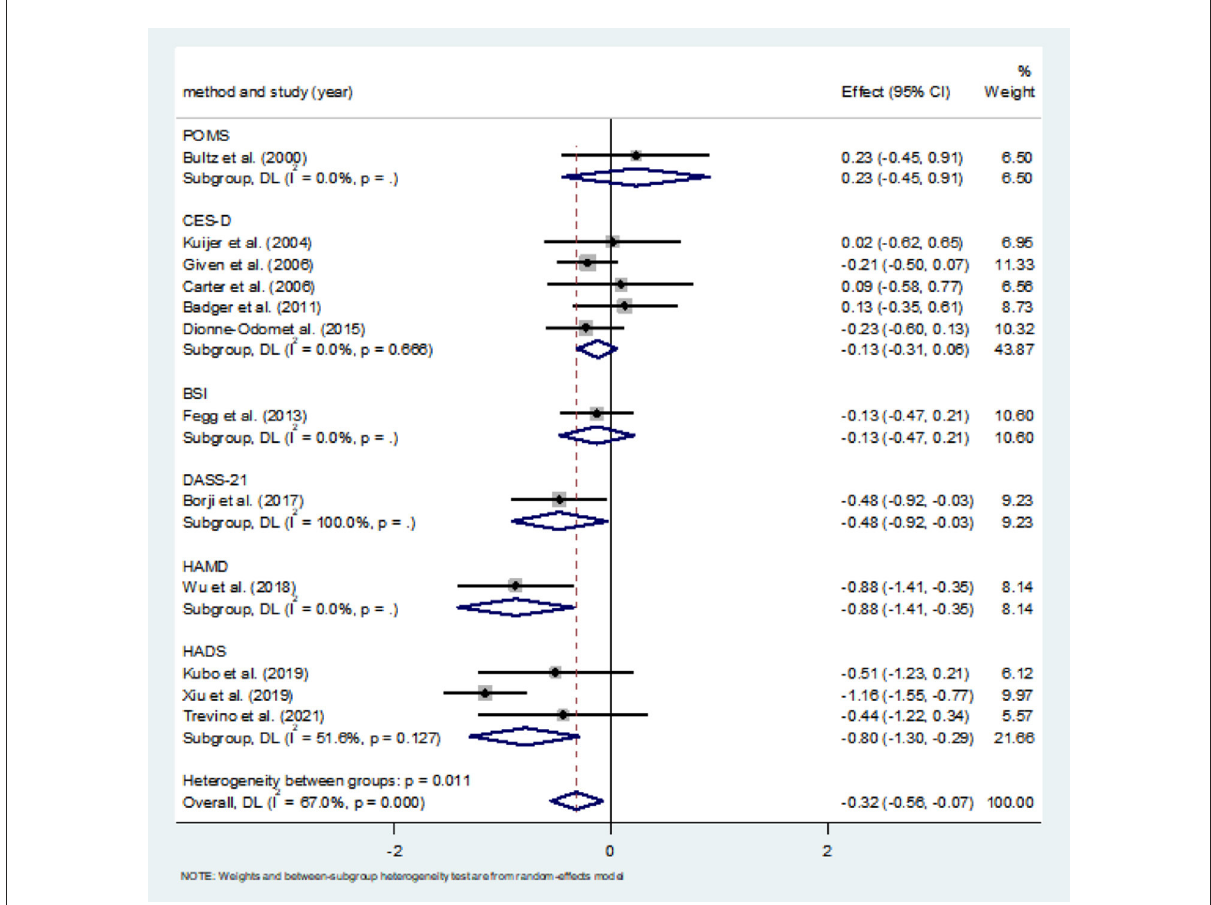
FIGURE7 Forest maps for subgroup analysis of effects on depression.